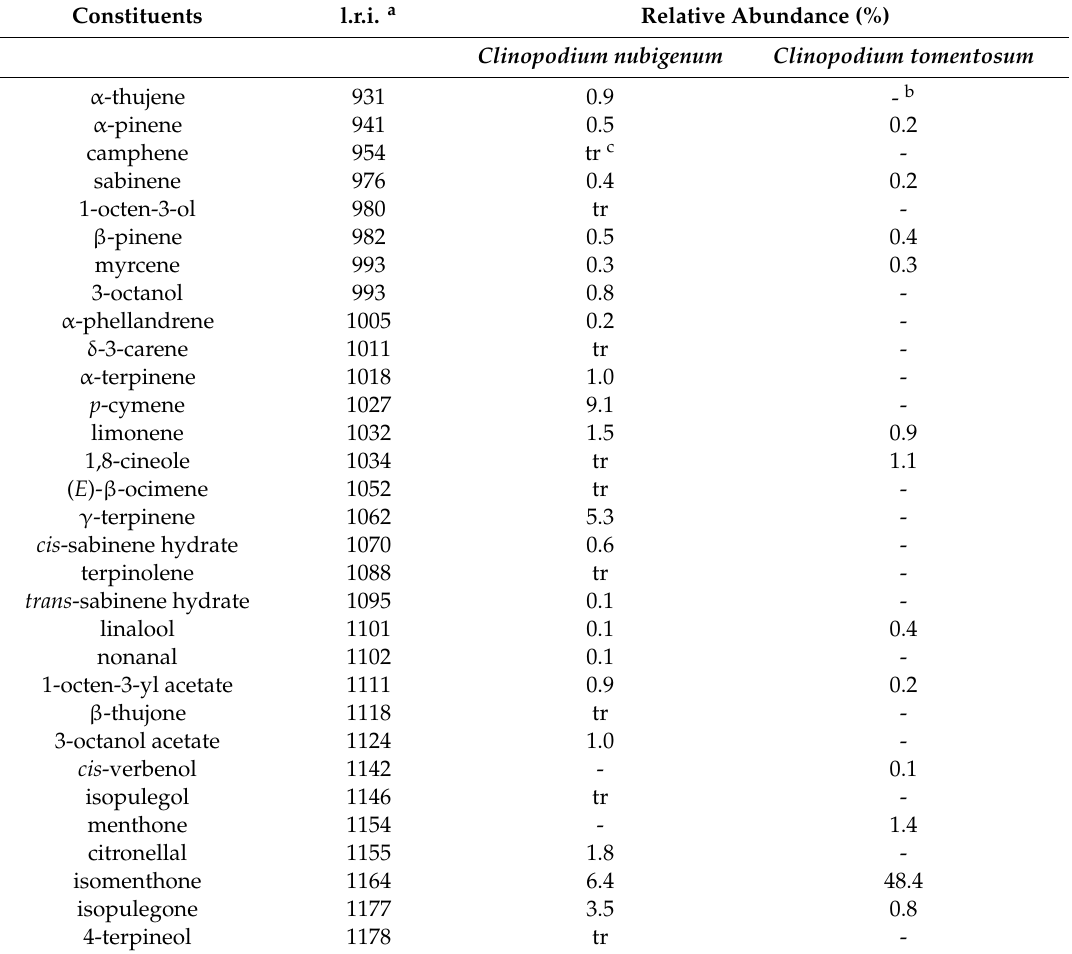
Table 1. Complete compositions of the essential oils extracted from flowering aerial parts of